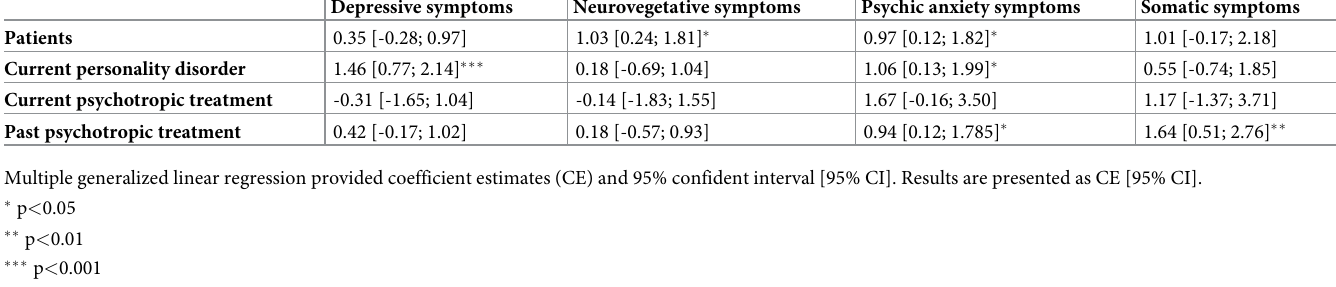
Neurovegetative symptoms Psychic anxiety